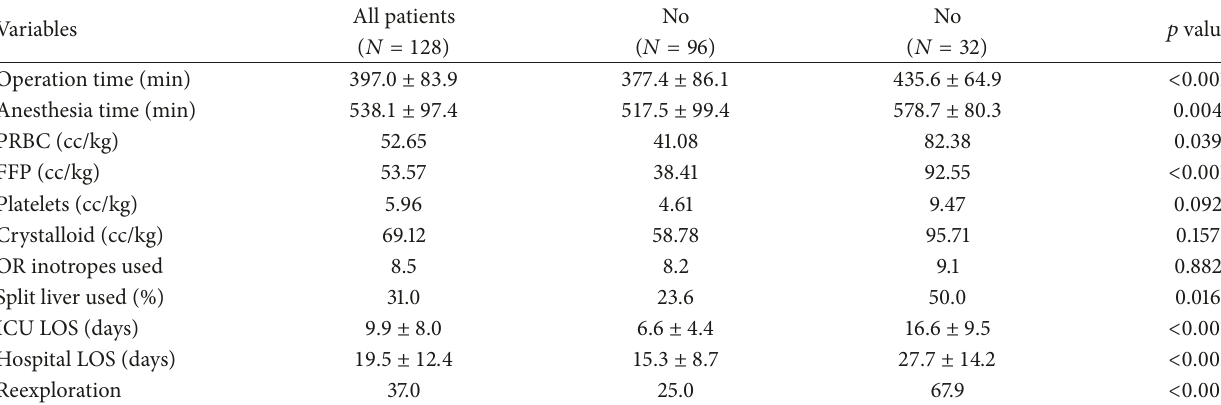
Table 2: Perioperative variables stratified according to PPMV status.